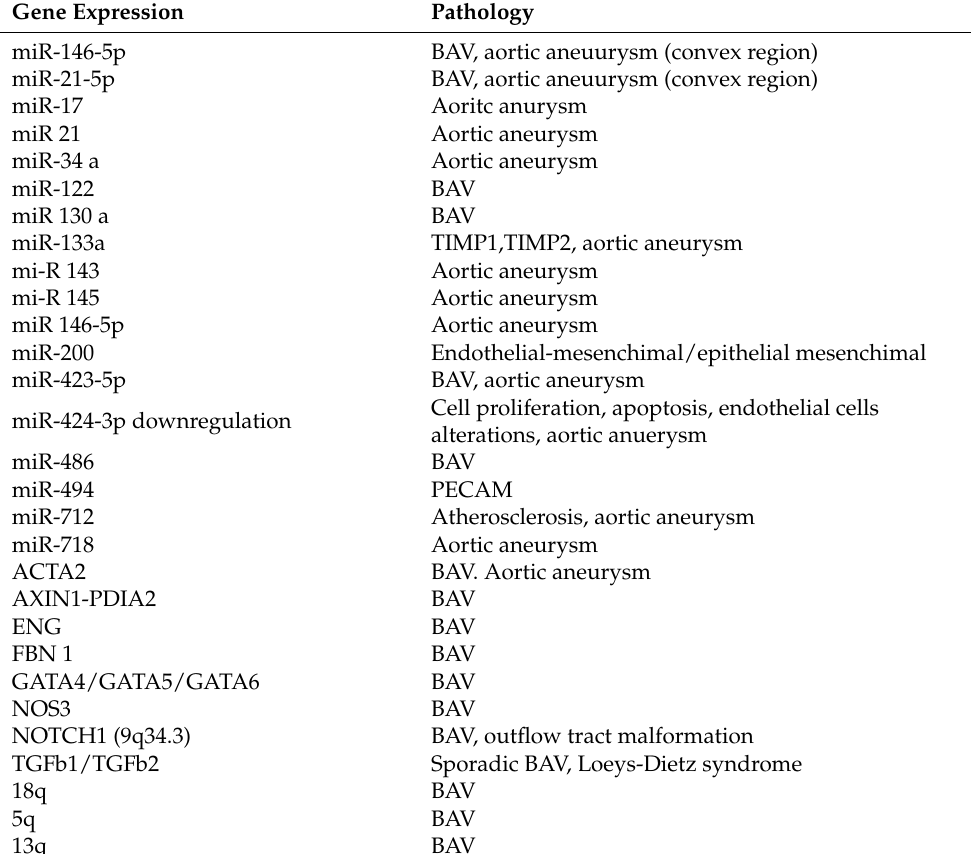
Table 2. Gene expression involved in valve and aortic diseases. ACTA 2: alfa actine 2, AXIN: gene encodes a cytoplasmic protein that contains a regulation of G-protein signaling (RGS) domain and a di- sheveled and axin (DIX) domain, BAV: bicuspid aortic valve, ENG: Endoglin, FBN1: fibrillin 1, GATA (sequence for transcription factors for zinc proteins’ binding DNA sequence), NOS3: nitric oxide synthase 3, NOTCH1 (gene encoding transmembrane proteins), PDIA2: protein disulfide isomerase family A member 2, PECAM-1: platelet endothelial cell adhesion molecule-1, TGF: transforming growth factor, TIMP: tissue inhibitor of matrix